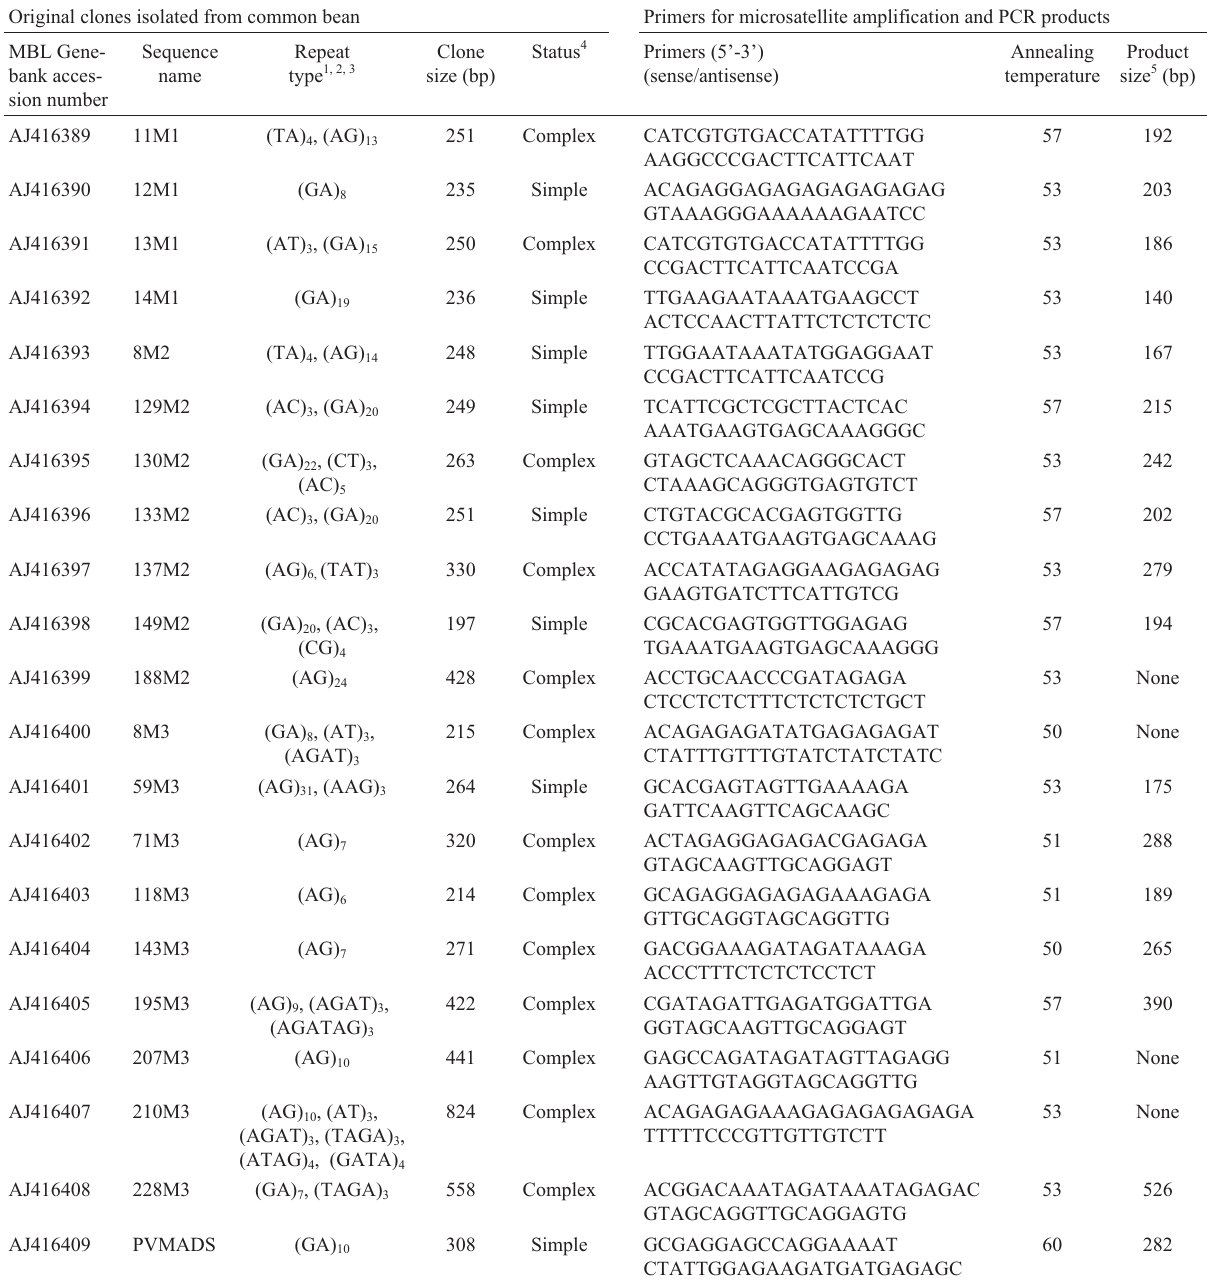
Table 1 - Description of the 21 microsatellite clones isolated from common bean, Phaseolus vulgaris L., and microsatellite amplification conditions. Original clones isolated from common bean Primers for microsatellite amplification and PCR